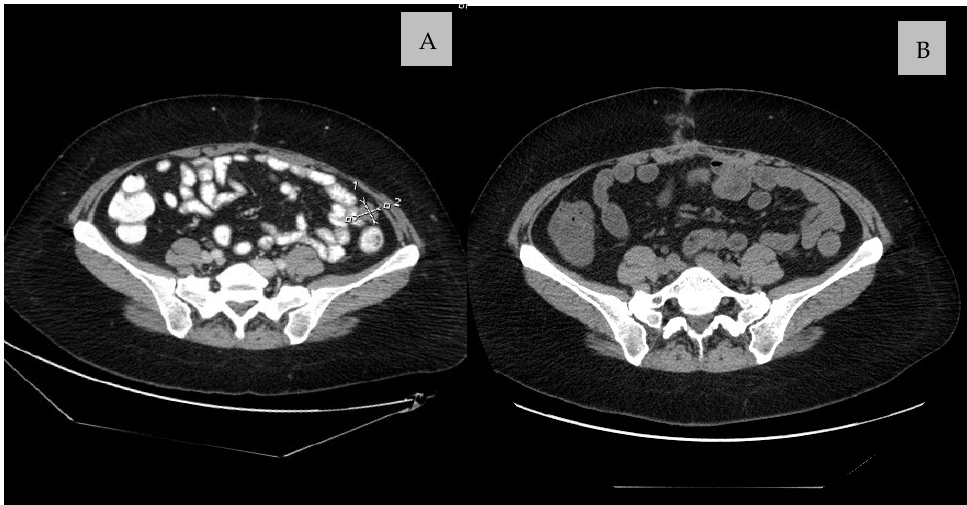
Figure 2. CT scan before ( A ) and after ( B ) resection of residual metastatic lesion in the abdominal cavity in young women with GIST with KIT exon 9 deletion mutation arising from the small intestine, after treatment with TKIs.